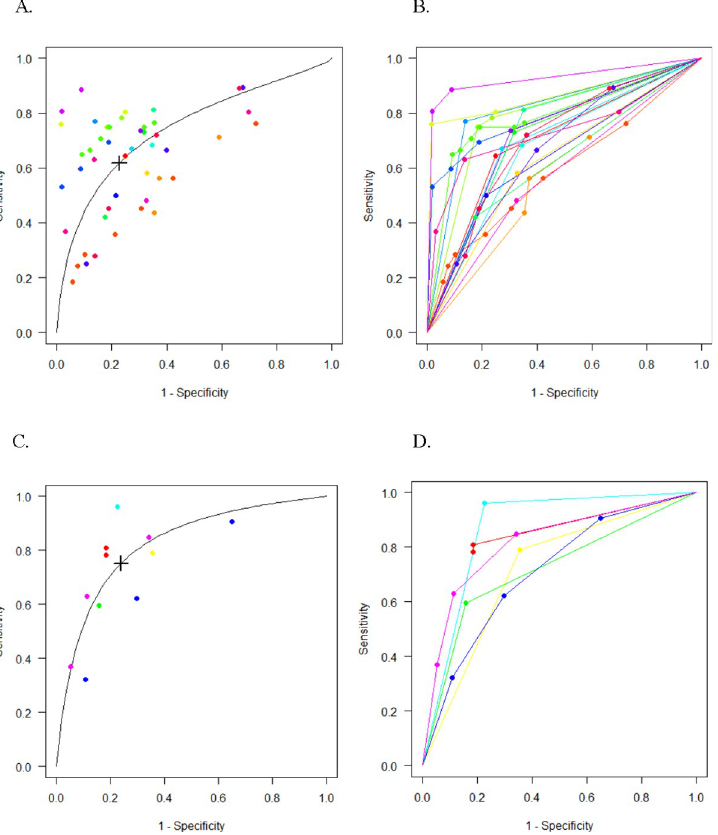
Fig 2. Multiple threshold SROC and ROC curves for detecting NASH. Multiple threshold SROC and ROC curves for CK-18 M30 (A-B) and M65 (C-D) in detecting NASH. Each point represents a reported threshold value, points of the same color represent thresholds reported within the same study. The x-axis indicates 1 –specificity, and the y-axis, sensitivity. The cross in the SROC curve indicates the Youden-based threshold value: A. Youden-threshold: 304 U/L, sensitivity: 0.61 (95% CI: 0.51–0.71), specificity: 0.81 (95% CI: 0.71–0.88), AUC: 0.75 (95% CI: 0.69–0.82) for CK-18 M30. C. Youden-threshold: 478 U/L, sensitivity: 0.75 (95% CI: 0.51–0.90), specificity: 0.76 (95% CI: 0.49–0.91), AUC: 0.82 (95% CI: 0.69–0.91) for CK-18